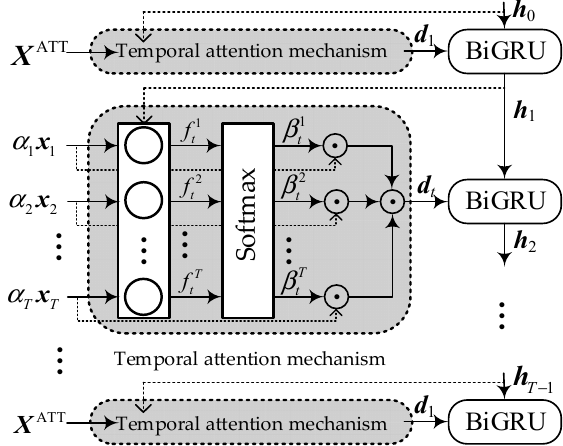
Figure 4. Temporal attention mechanism.